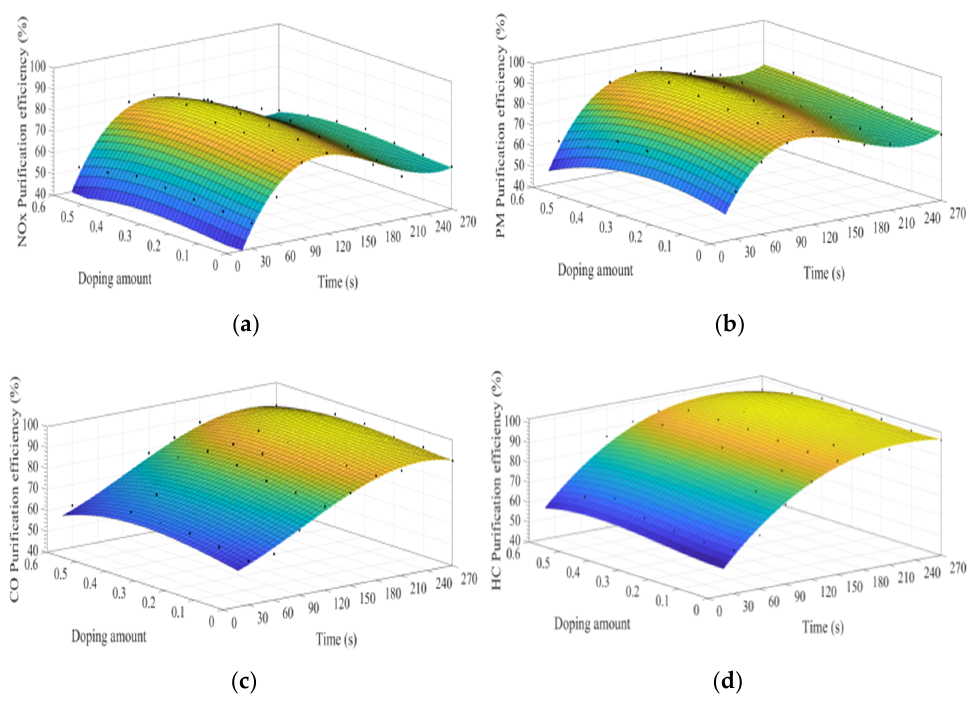
Figure 14. Purification efficiency curve of catalyst when B site was doped with manganese ions: ( a ) NO X ; ( b ) PM; ( c ) CO; and ( d ) HC.